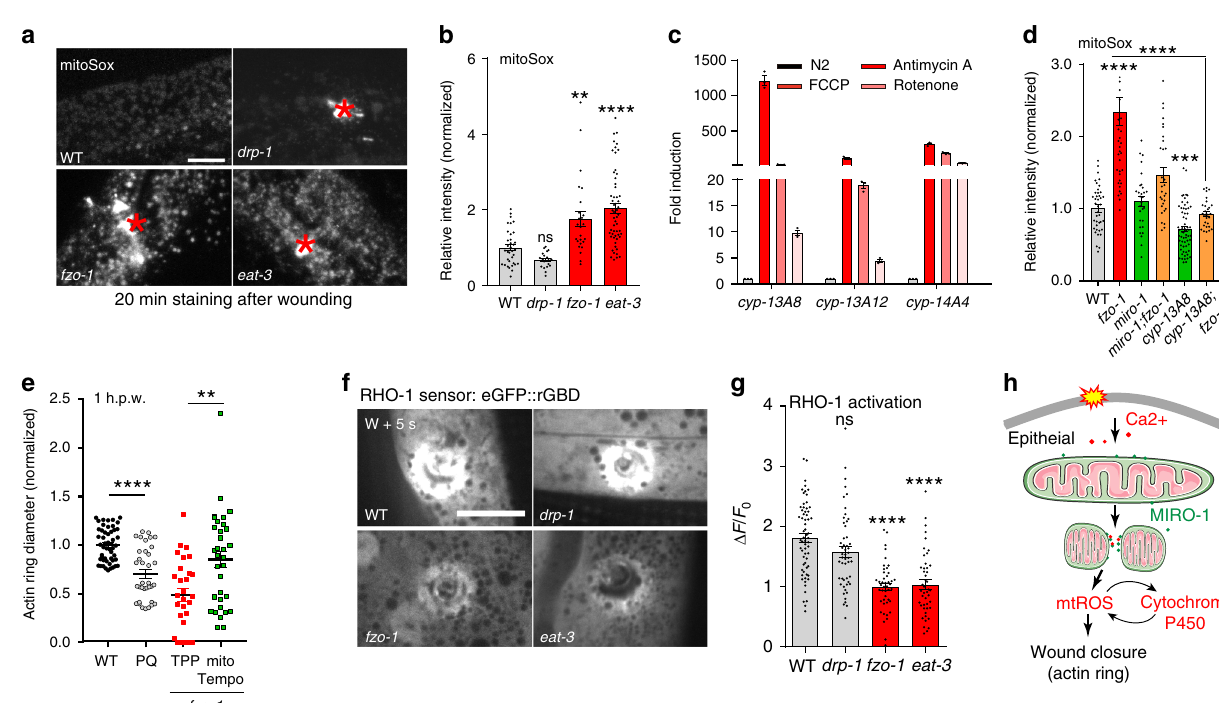
Fig. 7 Accelerated wound closure of fzo-1 mutant is dependent on mtROS. a Representative confocal images of mitoSox staining in WT and mutants. b Representative confocal images of mitoSOX staining in WT, drp-1(tm1108) , fzo-1(tm1133), and eat-3(tm1107) mutants 20 min after needle wounding. Red asterisks indicated wound sites. Right, Quantitation of mitoSOX intensity, normalized to WT (WT, n = 35; drp-1 , n = 20; fzo-1 , n = 25; eat-3 , n = 56 animals). Bars indicate mean ± SEM, ns, P = 0.3413, ** P = 0.0016, **** P < 0.0001, One-way ANOVA Dunnett ’ s test (versus WT). c qPCR analysis of Cytochrome P450 genes after treatment antimycin A, Rotenone and FCCP. N = 3 independent experiments. Bars indicate mean ± SEM. d Quantitation of mitoSOX intensity, normalized to WT (WT, n = 40; fzo-1 , n = 38; miro-1 , n = 29; fzo-1;miro-1 , n = 30; fzo-1;cyp-13A8 , n = 30; cyp-13A8 , n = 62 animals). Bars indicate mean ± SEM, ns, P = 0.2472, *** P = 0.0005, **** P < 0.0001, versus WT or fzo-1 animal . two-tailed unpaired t -test. e Quantitation of F-actin ring diameter in TPP and mitoTempo treated worms (WT, n = 51; PQ, n = 35; fzo-1-TPP , n = 29; fzo-1-mitoTempo , n = 33 animals). Paraquat (PQ) treatment as a control. Bars indicate mean ± SEM, ** P = 0.0015, **** P < 0.0001, two-tailed unpaired t -test. f , g Mitochondrial fusion mutants reduced local activation of RHO-1 small GTPase at wound sites (see also Supplementary Movie 14). f Representative confocal images of RHO-1 GTPase sensor eGFP::rGBD in the adult in WT or drp-1 , fzo-1, and eat-3 mutant. Pcol-19-eGFP::rGBD(juEx3025) strain were used for wounding and imaging. Scale bars ( a , f ), 10 μ m. g Quantitation of eGFP::rGBD fl uorescent intensity change in WT and mutants after wounding (WT, n = 52; drp-1 , n = 51; fzo-1 , n = 44; eat-3 , n = 46 animals). Bars indicate mean ± SEM, ns, P = 0.1448, **** P < 0.001, One-way ANOVA Dunnett ’ s test. Source data are provided as a Source Data fi le. h A model for how mitochondrial fragmentation promotes epidermal wound